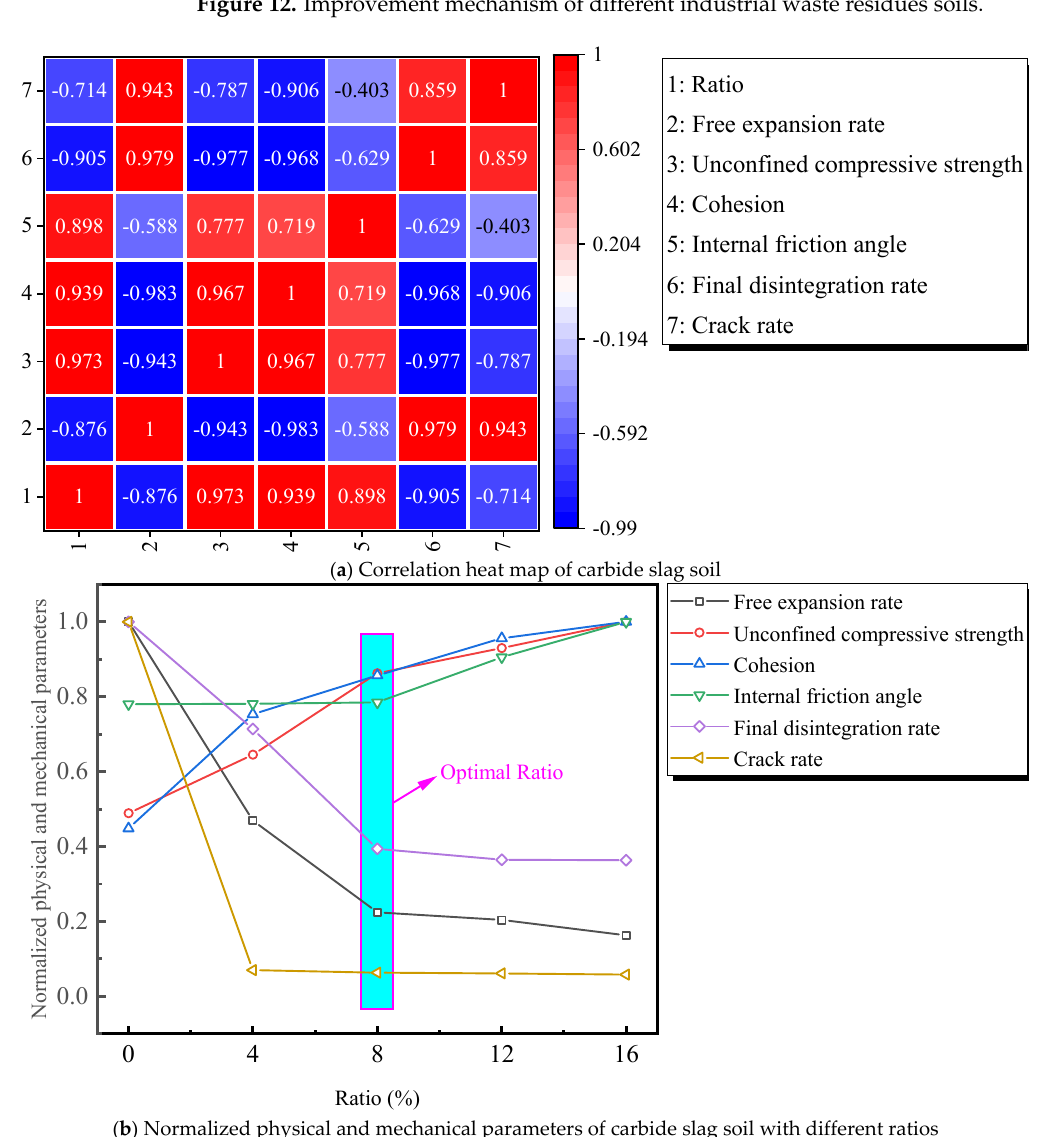
Figure 12. Improvement mechanism of different industrial waste residues soils.